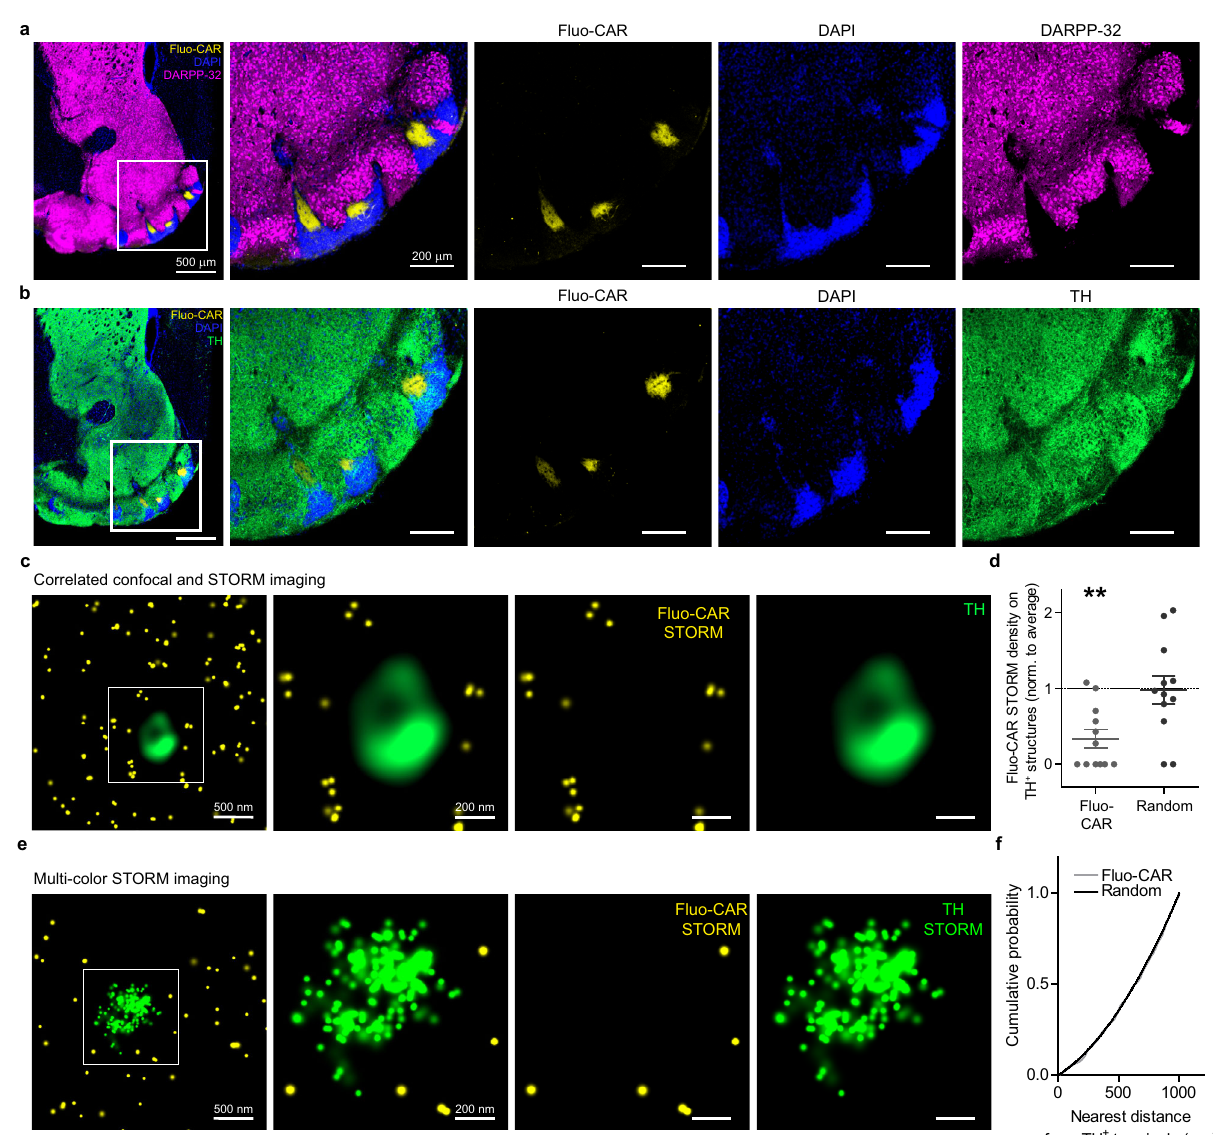
Fig. 4 Correlated PharmacoSTORM molecular and anatomical imaging visualizes Fluo-CAR binding surrounding dopaminergic nerve terminals. a , b Comparative analysis of the distribution of fl uo-cariprazine-binding sites and well-known dopaminergic signaling proteins in the ventral part of the mouse forebrain. a Fluo-CAR-treated slices (300 nM) were immunostained for DARPP-32. Neither the hilar subregion (outlined by yellow Fluo-CAR binding) nor the cell bodies in the granular subregion (visualized by blue DAPI staining) of the Islands of Calleja contain the striatal marker protein DARPP-32 (purple). b In contrast to the characteristic DARPP-32 immunonegativity, immunostaining for tyrosine hydroxylase (TH) in the Islands of Calleja suggests that dopaminergic axons densely innervate this brain region. c Correlated confocal and PharmacoSTORM imaging of TH-containing-varicosities and Fluo-CAR binding, respectively. Although the dopaminergic varicosities are surrounded by a high density of Fluo-CAR binding sites, Fluo-CAR apparently avoids TH- immunopositive dopaminergic nerve terminals. d Quantitative nanoscale spatial analysis of Fluo-CAR binding in relation to dopaminergic afferents of the Islands of Calleja. Data are normalized to the average density of PharmacoSTORM localization points (LPs) on each image. Note that if the same number of Fluo-CAR LPs would be randomly distributed then TH-containing varicosities would bear the average density on each image. Two-tailed Wilcoxon signed- rank test was used to test if median is different from 1 ( n = 12, data are from fi ve animals, presented as mean ± SEM; P = 0.0048 for Fluo-CAR LPs, P = 0.7836 for random distribution). e Dual-color PharmacoSTORM and ImmunoSTORM imaging of Fluor-CAR labeling and TH-immunostaining. f Random nanoscale distribution of Fluo-CAR-binding sites around dopaminergic axon terminals. To test the nanoscale relationship between the site of dopamine synthesis and dopamine binding sites, the nearest-neighbor distance of each Fluo-CAR-binding site was measured from a 2D convex hull fi tted onto the TH ImmunoSTORM LPs. The identical cumulative distribution of Fluo-CAR LPs and randomized LPs (Kolmogorov – Smirnov test, two-tailed P = 0.8749) indicates the lack of speci fi c Fluo-CAR binding site nanoclusters in the proximity of TH + boutons as one would expect in case of synaptic specializations and rather suggests volume transmission as the primary mode of dopaminergic